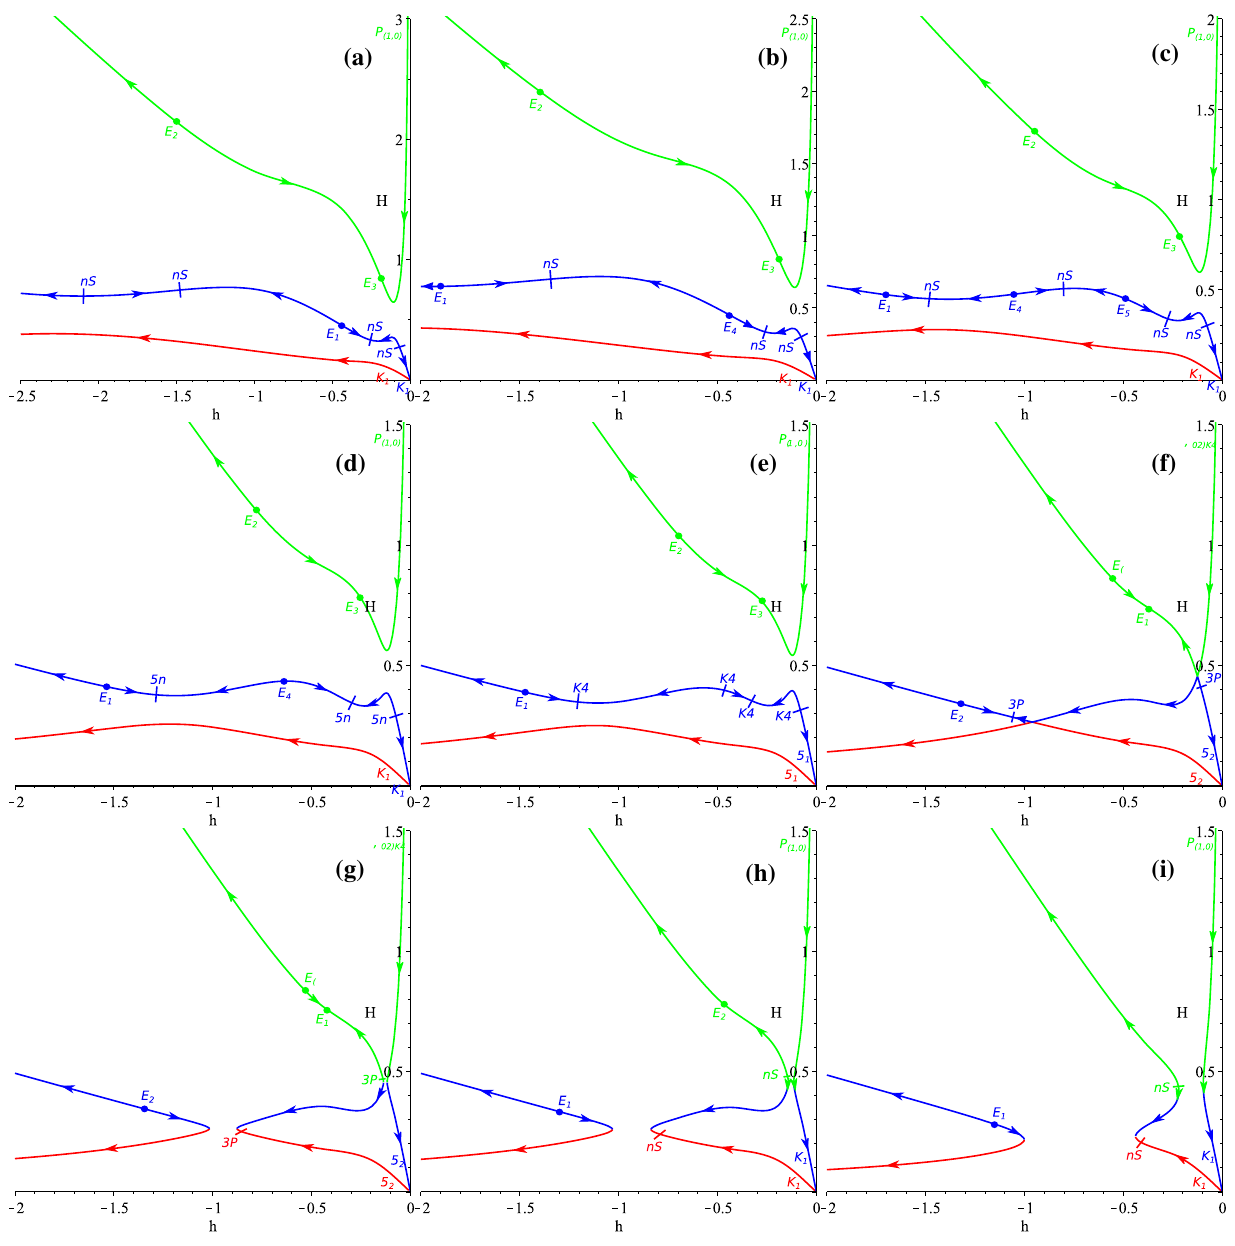
Fig. 2 The fine structure of the solutions in the α > 0, β > 0 D =